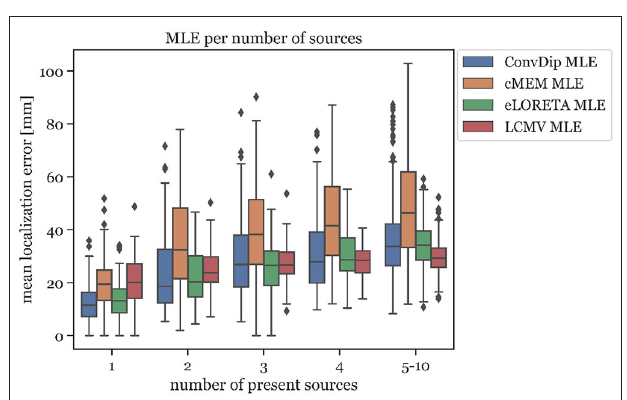
FIGURE 5 | Mean localization error for each inverse algorithm grouped by the number of present source clusters. The rightmost column displays the results for samples containing between 5 and 10 source